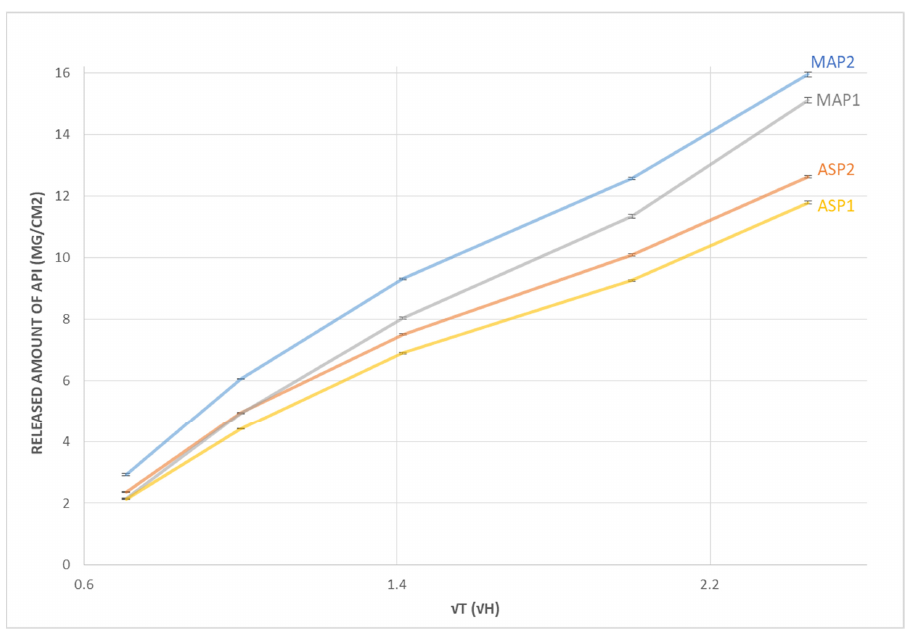
Figure 1. Release profiles of L-ascorbic acid derivatives from investigated emulgels (ASP1, MAP1, ASP2 and MAP2).